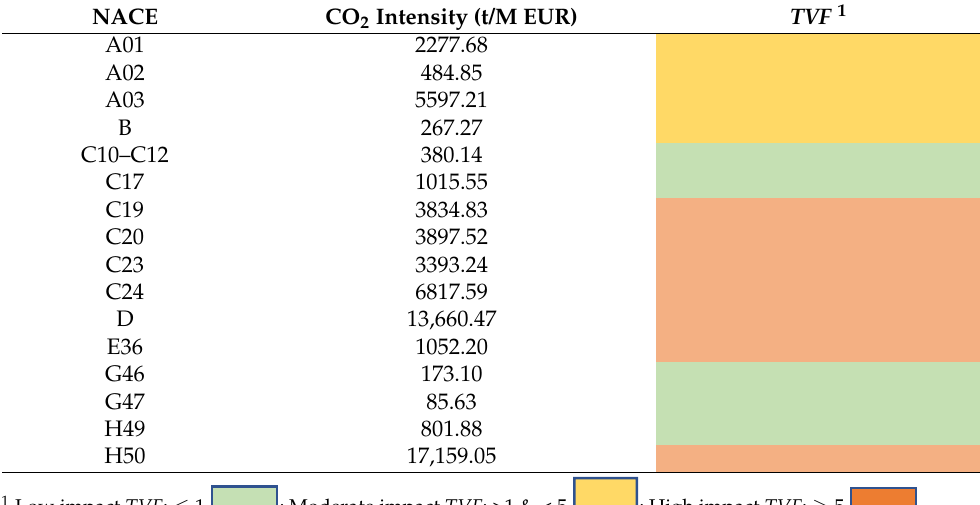
Table 2. The heatmap of emission-intensive sectors.